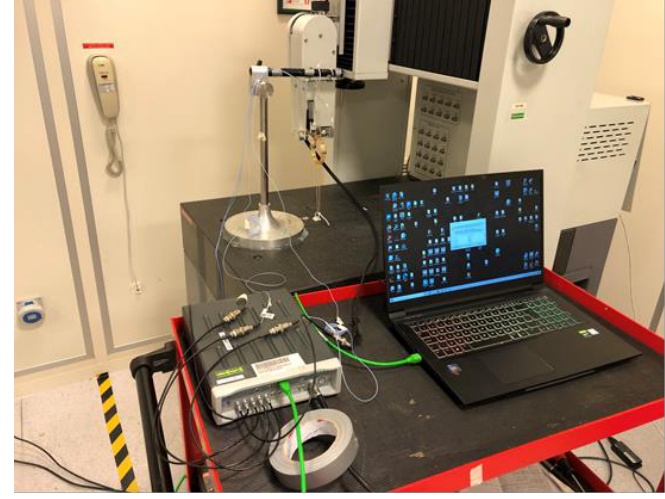
Figure 3. Modal test robot and data acquisition test setup.